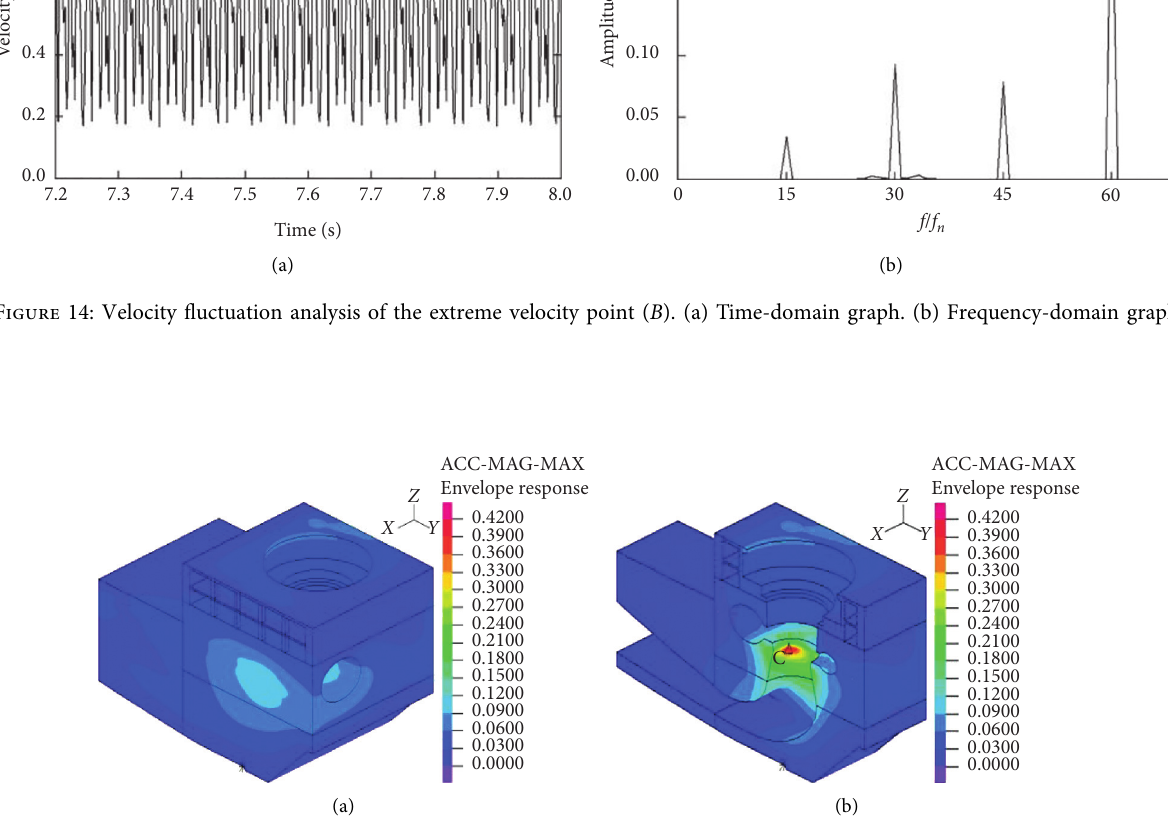
Figure 15: Extreme acceleration distribution of the concrete structure (m/s 2 ). (a) In three-dimensional view. (b) In section